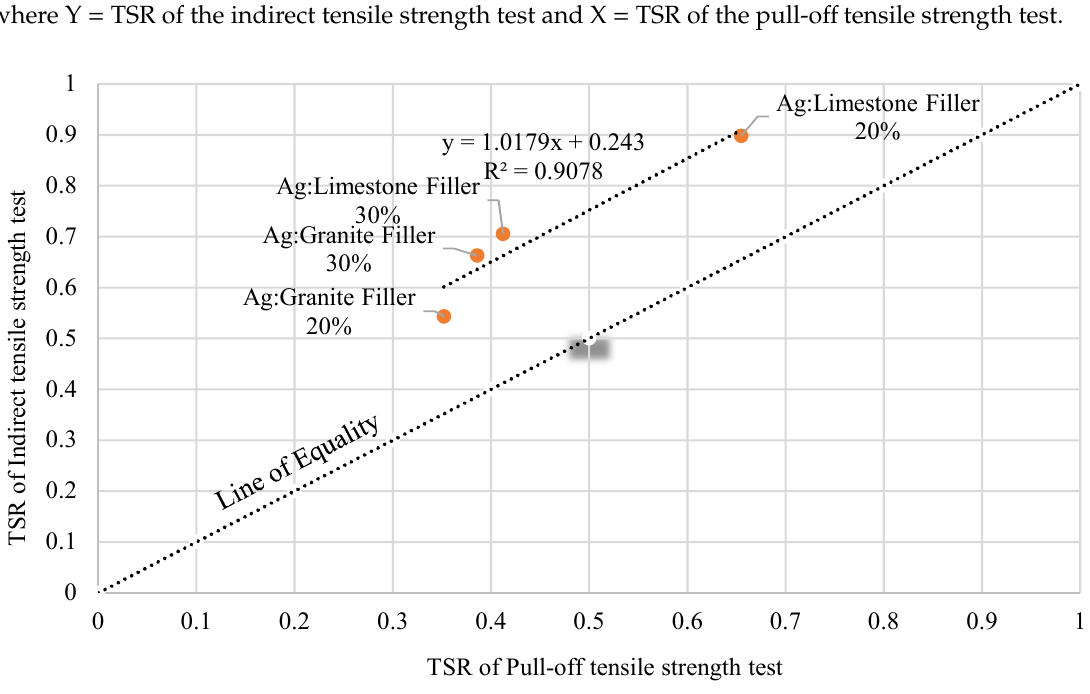
Figure 9. Correlation of TSR between ITS and POTS tests.